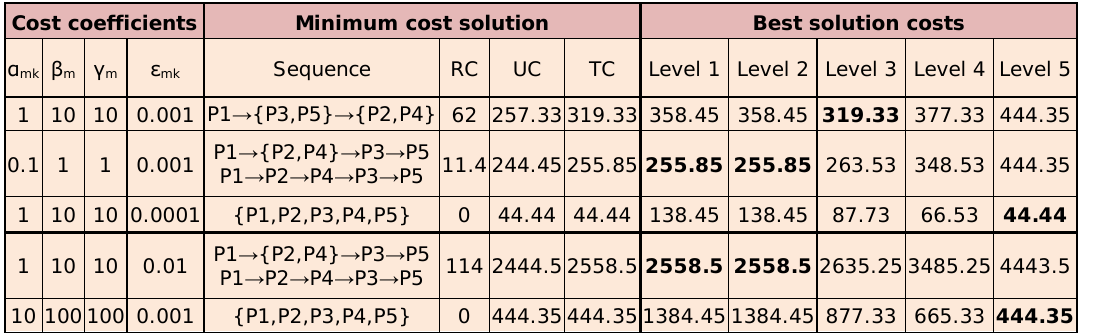
Table 5. Results for different cost coefficients (RC=Reconfigurations cost, UC=Underutilization cost, TC=Total